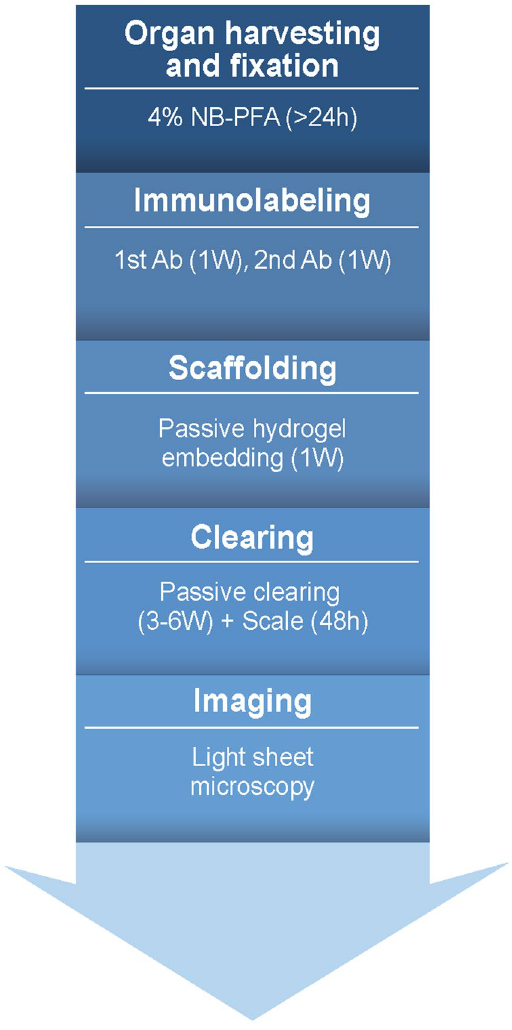
Figure 1. The WOBLI method outline. Fresh tissues were passively fixed in 4% PFA for at least 24 hours. After fixation, tissues were permeabilized and then immunolabeled for lymphatic vessels using LYVE1 antibody. Labeled tissues were scafolded in hydrogel and subsequently cleared and placed in Sca l eA2 solution. Light-sheet microscopy was utilized for the three-dimensional imaging of the blood and lymphatic